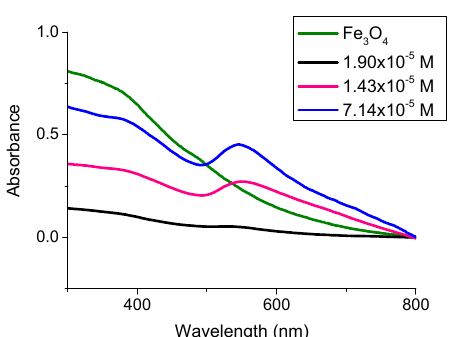
Figure 8. UV-Vis spectra of each PSS-Magnetite concentration titrated with PAH-stabilised gold after five magnetic separations.